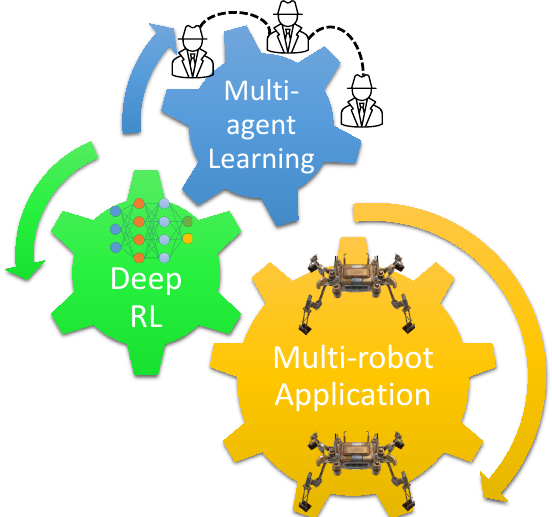
Figure 1. The main contribution of this article is that we have reviewed the latest multi-robot application papers that use multi-agent learning techniques via deep reinforcement learning. Readers will be able to find out how these three concepts are used together in the discussed studies and this survey will provide them with insight into possible future developments in this field, which, in turn, will advance the